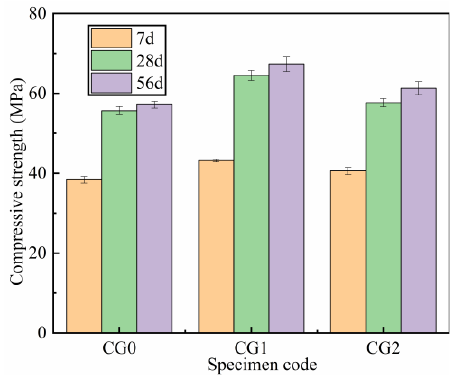
Figure 12. Compressive strength of ferrochrome slag concrete.